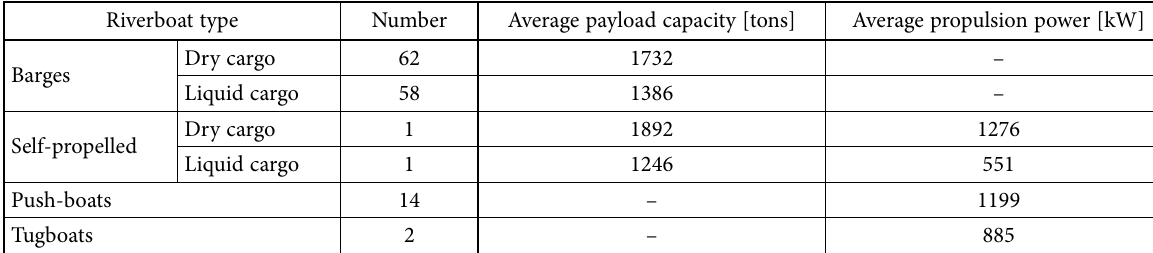
Table 1. JRB’s riverboat